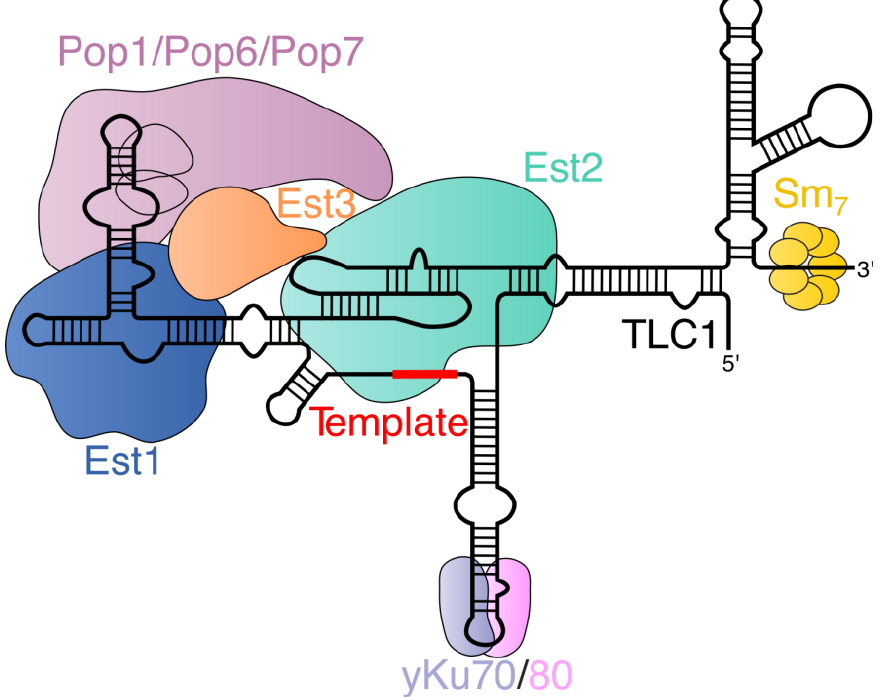
Figure 1. Scheme of telomerase holoenzyme’s composition in budding yeast. The secondary structures of TLC1 and protein components and the interactions between them are depicted in a simplified way, but in a manner consistent with current data. TLC1 works as a flexible scaffold for associated proteins. Ever shorter telomere (Est) proteins were first identified as important for telomere homeostasis. Est2 binds the pseudoknot (not marked) and template region of TLC1. Est1 and Pop proteins bind the same TLC1 arm. Pop proteins facilitate binding of Est1 and Est2 (and Est3 probably). Est3 does not interact with TLC1 and associates through Est1 or/and Est2 depending on the type of yeast. yKu70/80 heterodimer binds another TLC1 arm. Heptameric Sm 7 protein ring protects the 3′ end of TLC1.